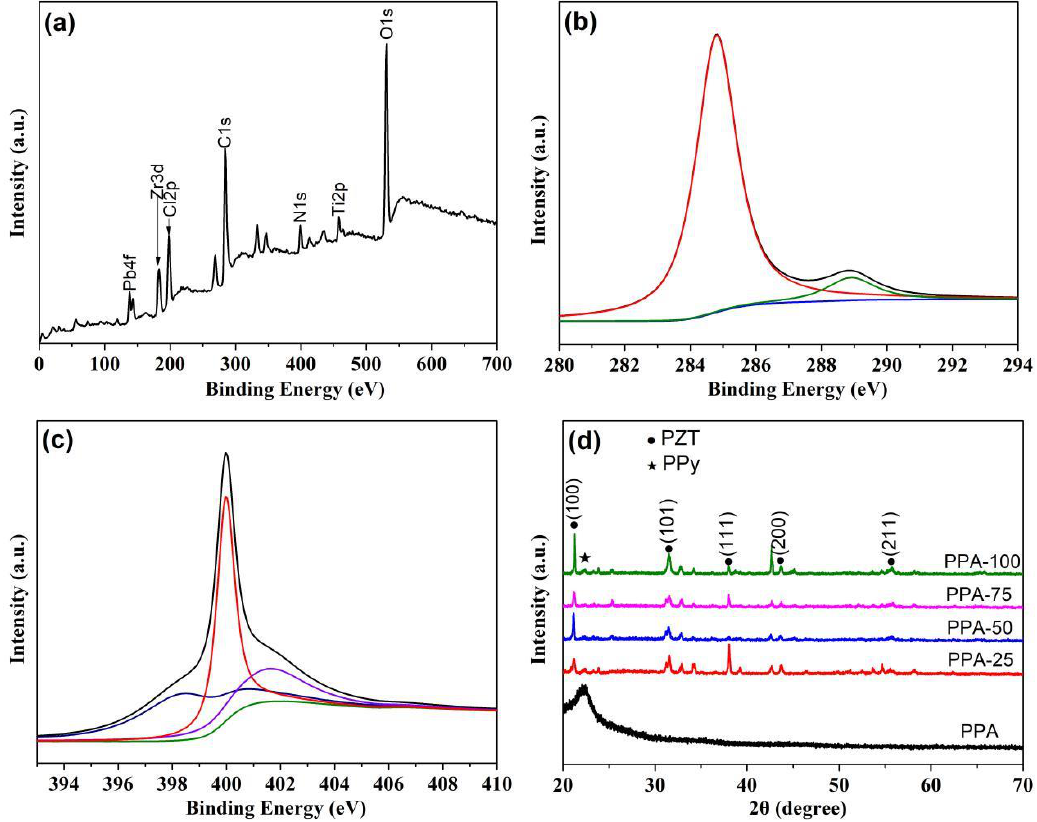
Figure 4. The nitrogen adsorption and desorption isotherm and the pore size distribution plot of PPA-75.